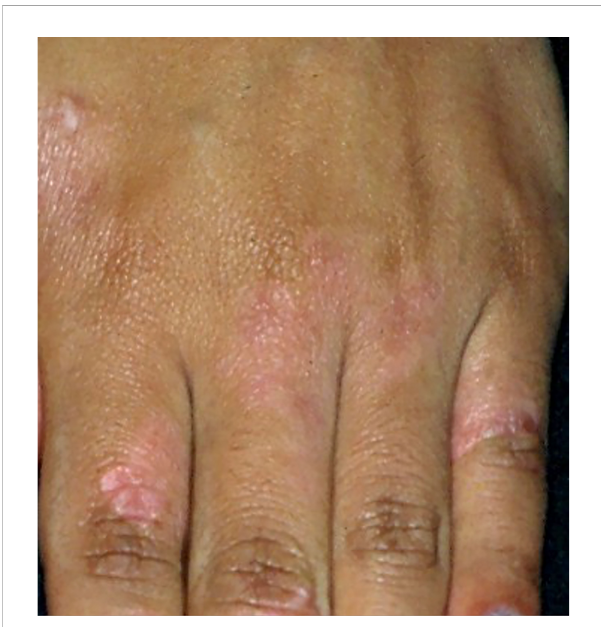
FIGURE 3 Pagetoid reticulosis. Psoriasiform plaques on the dorsum of the hand.